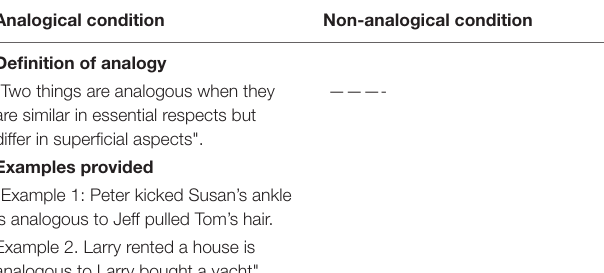
TABLE 1 | Instructions given to participants Experiment 1.